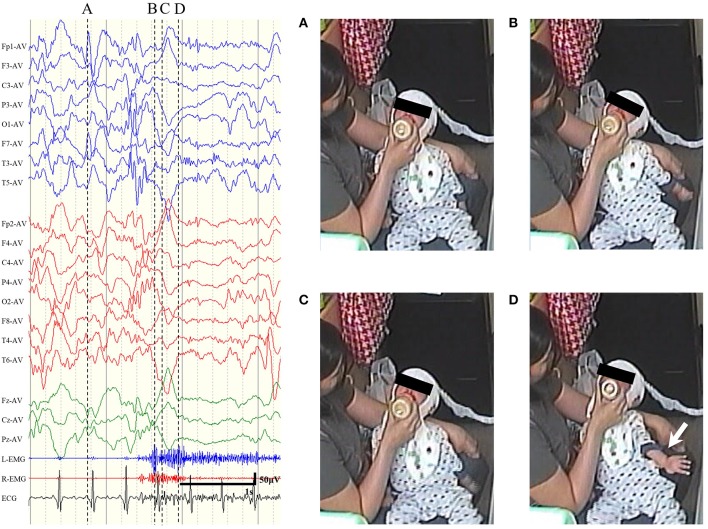
Representative examples of sequential seizure manifestation for epileptic spasms with biphasic muscular contractions of patient 8, pointed out by the dotted line. (A) Prior to the seizure. (B) At the first peak of the electromyogram (EMG). The neck and the trunk extended. (C) At the interval between two EMG peaks. The trunk looked slightly relaxed. (D) At the second peak of EMG. The left arm spastically extended out (white arrow).